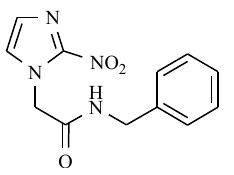
Figure 19. Benznidazole.